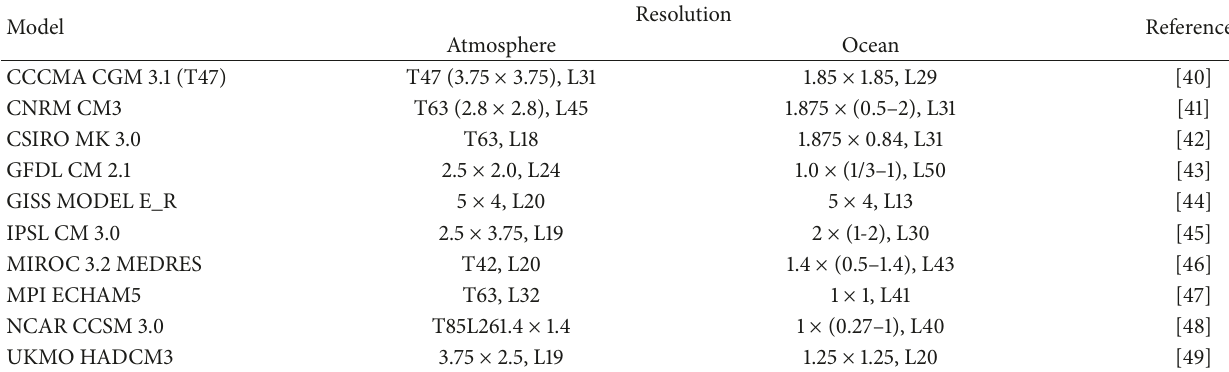
Table 1: CMIP3 climate model, resolution, and main